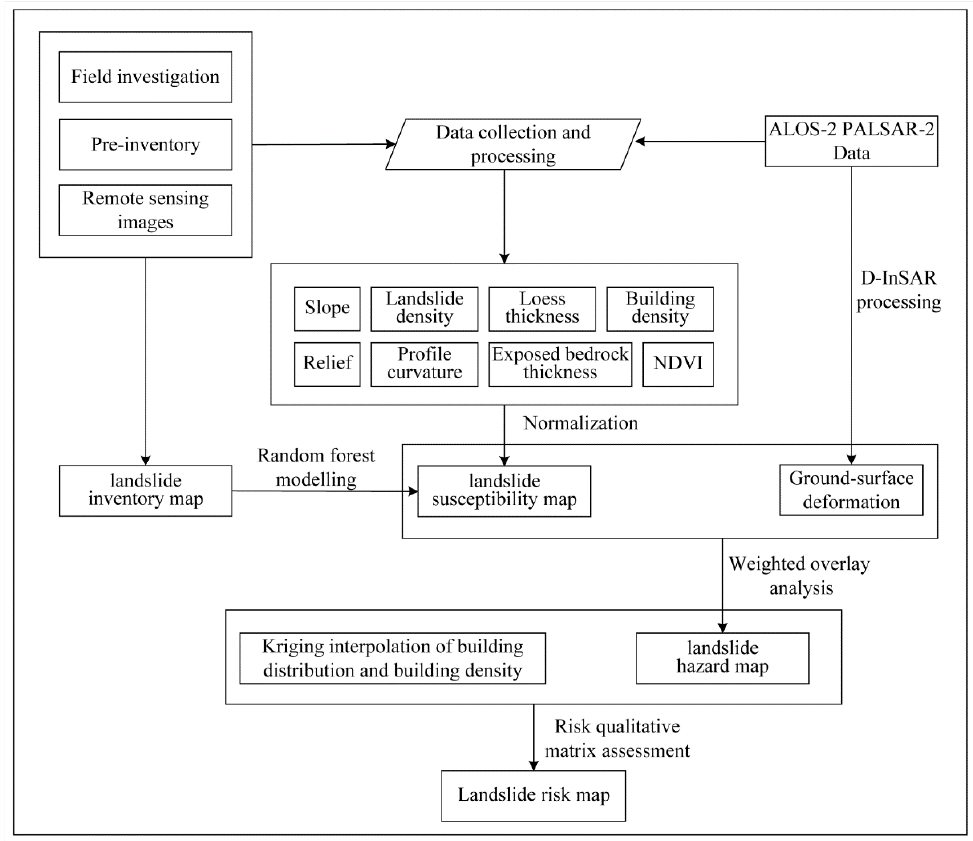
Figure 2. The flowchart of landslide risk assessment in the present study.